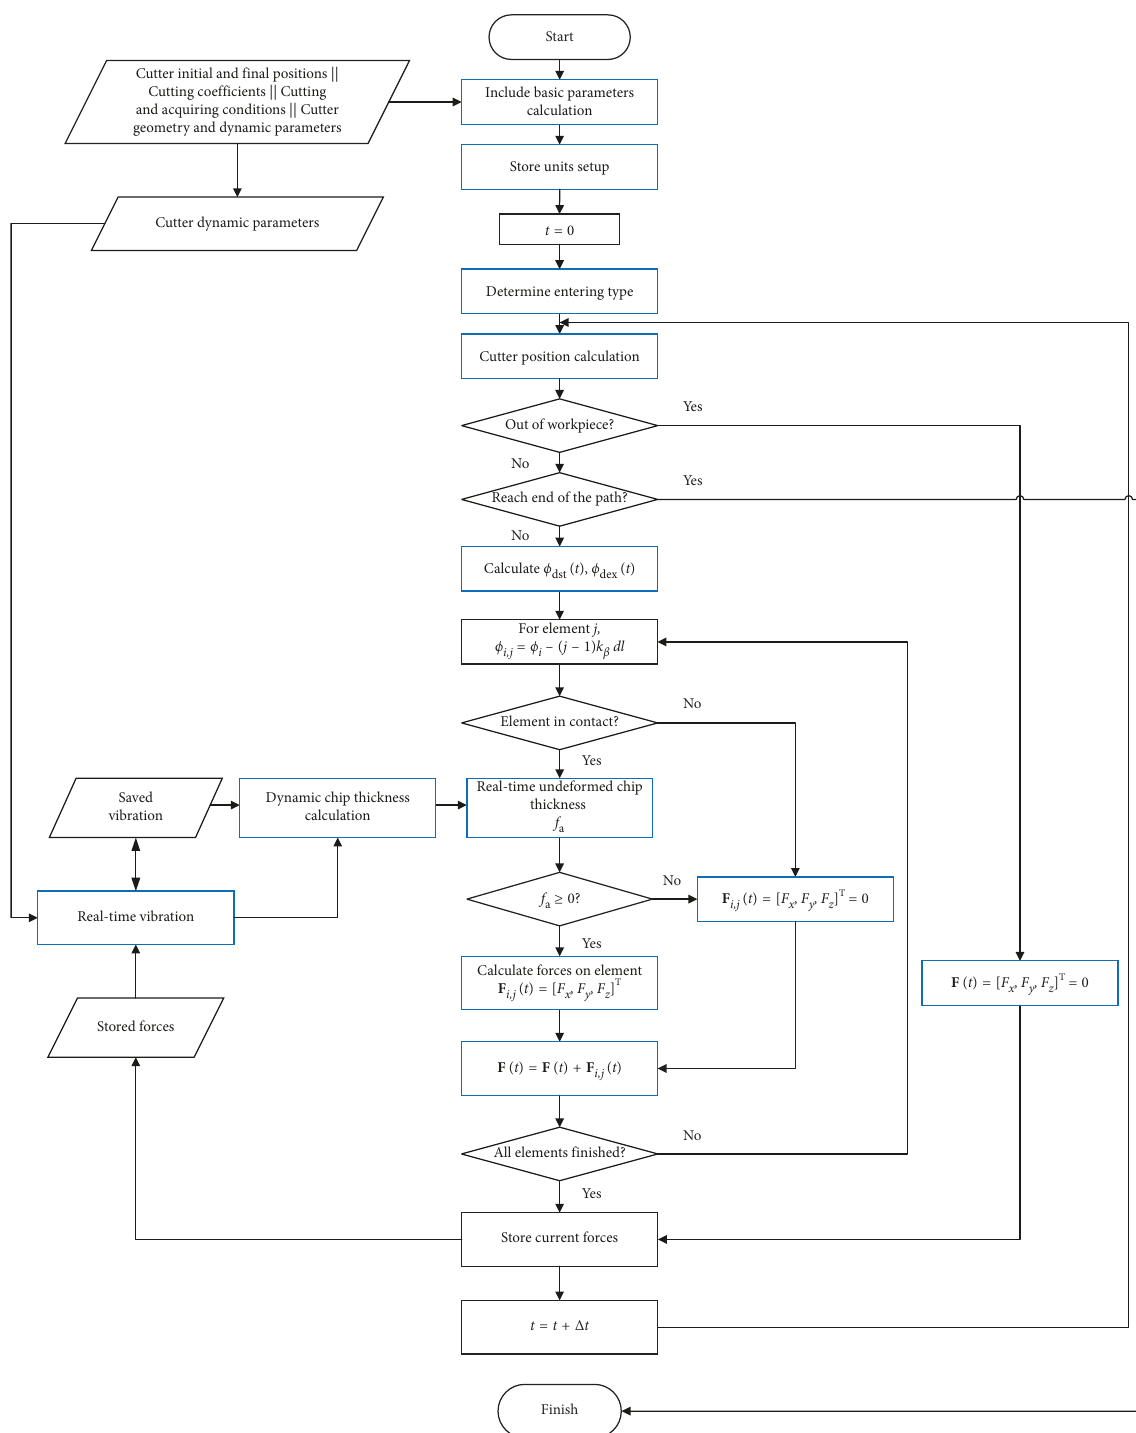
Figure 12: Flow chart of the cutter entering workpiece for two